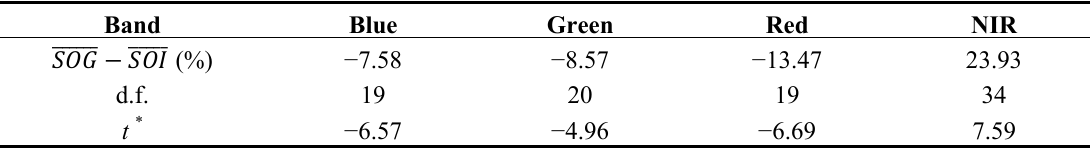
Table 1. Welch’s t -test of measured multispectral reflectances of shadow areas in the QuickBird blue, green, red, and near infrared (NIR) bands a . Band Blue Green Red NIR